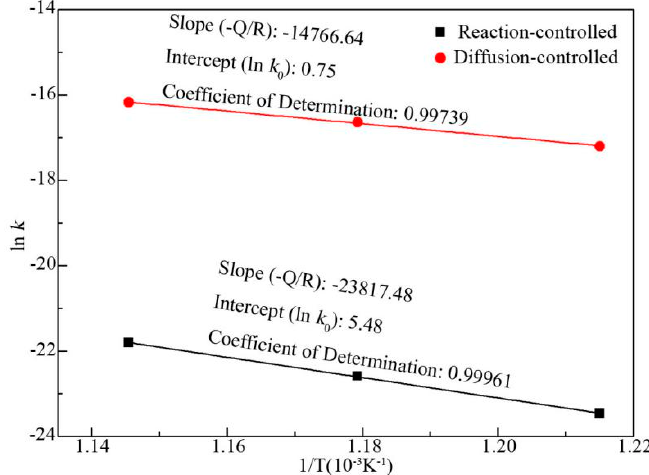
Figure 6. ln k versus the reciprocal temperature for two different growth mechanisms.